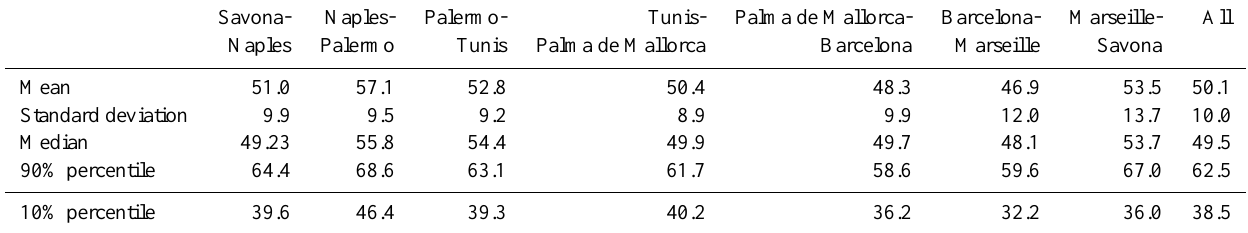
Table 1. Statistics on ozone concentrations (in ppbv) for each cruise leg for the periods June, July, August 2006 and 2007. Savona-